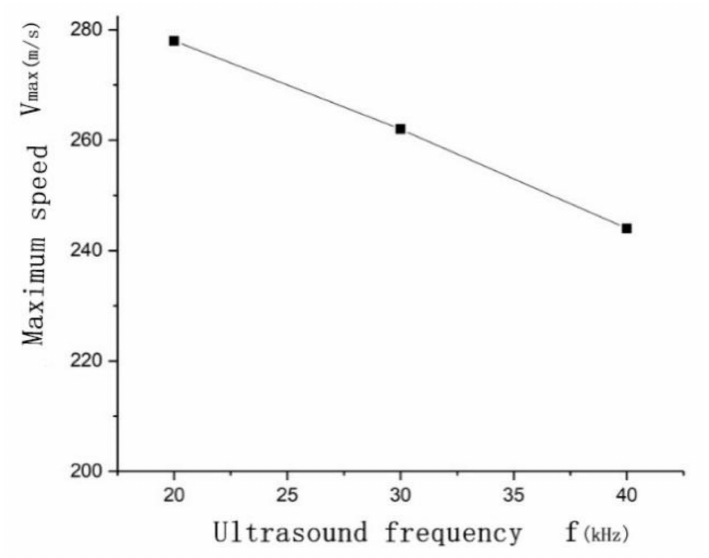
Figure 4. The effect of the initial radius of the bubble on the maximum velocity of the microjet.